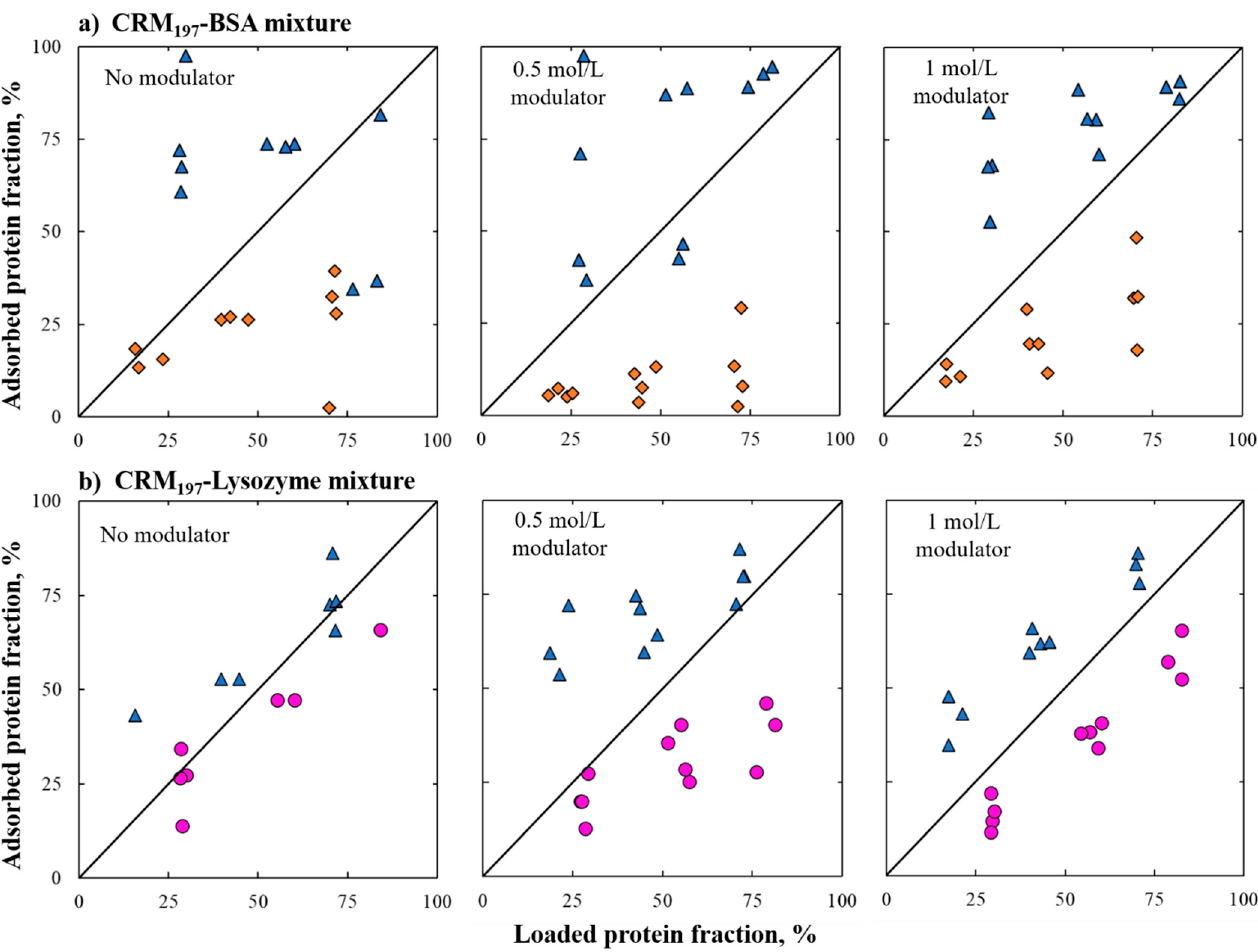
Figure 4. Parity plots describe the relationship between adsorbed and loaded protein fractions at different salt concentrations. Blue triangles represent CRM 197 fractions, pink circles represent lysozyme fractions and orange diamonds represent BSA fractions. Section ( a ) BSA–CRM 197 and section ( b ) CRM 197 –lysozyme mixture.